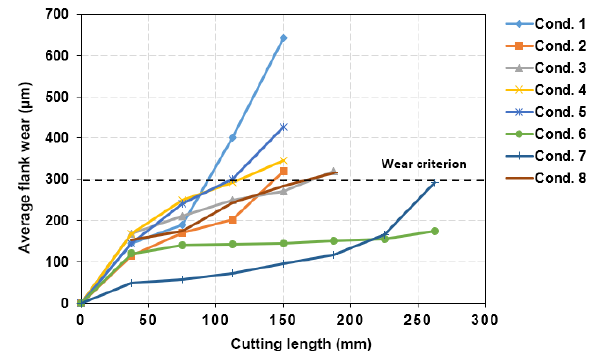
Figure 6. Average flank wear progression vs. cutting